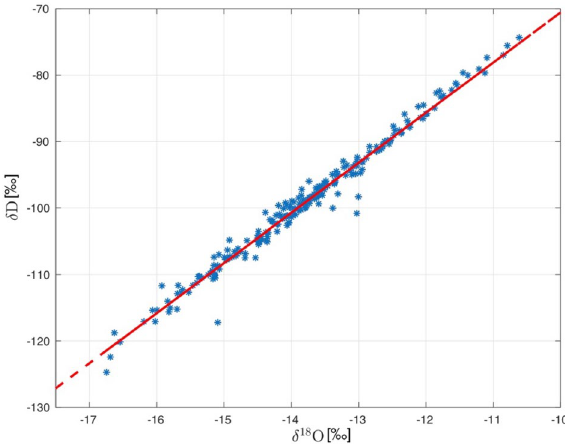
Figure 6. Results from co-isotopic analysis of the WSS ice core. δD and δ 18 O are closely correlated (r = 0.99). Linear regression results in a slope of 7.5, close to the global meteoric water line. Figure made with licensed software MATLAB R2019 (https ://www.mathw orks.com).